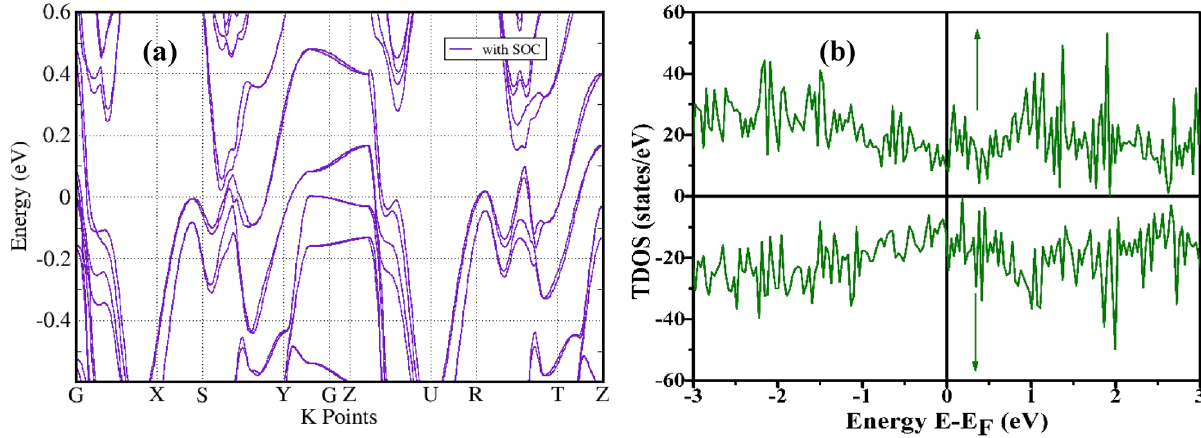
Figure 4. ( a ) Bulk band structure of T d -MoTeP with inclusion of SOC, ( b ) Spin-resolved Total DOS for defect induced